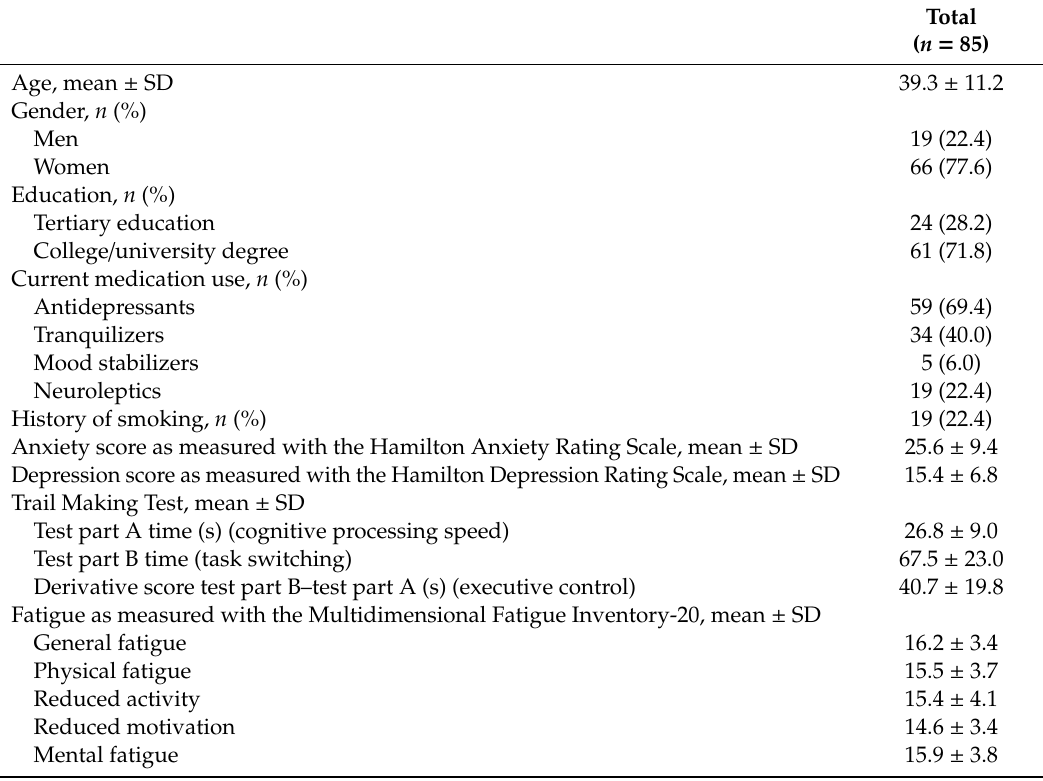
Table 1. Baseline characteristics and cross-sectional clinical and cognitive measurements for the study